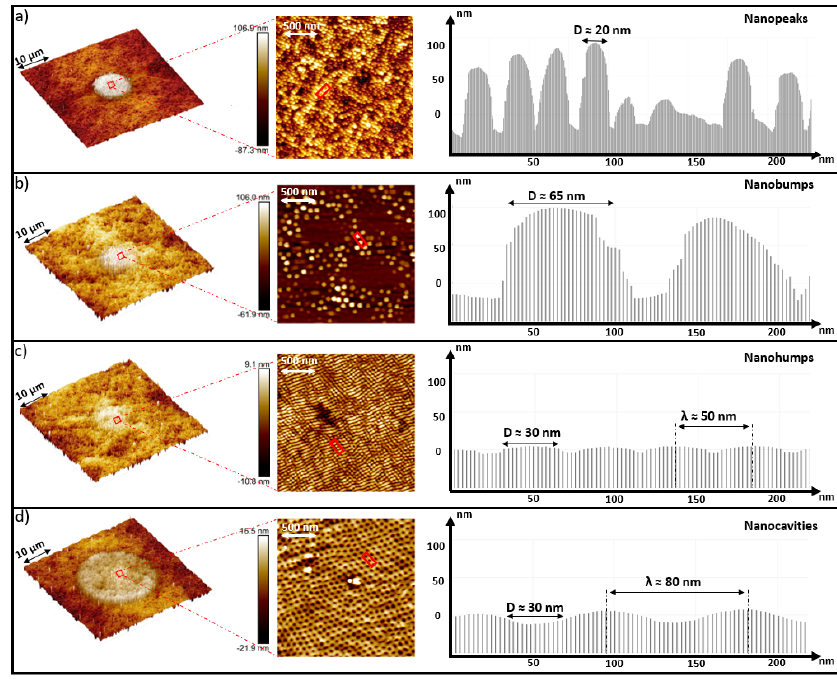
Figure 3. 3D AFM images of the principal nanopatterns ( a – d ) at different scales, presenting the laser spot region. A scan profile was performed for each type of the principal nanostructures presenting the shape and the periodicity of each